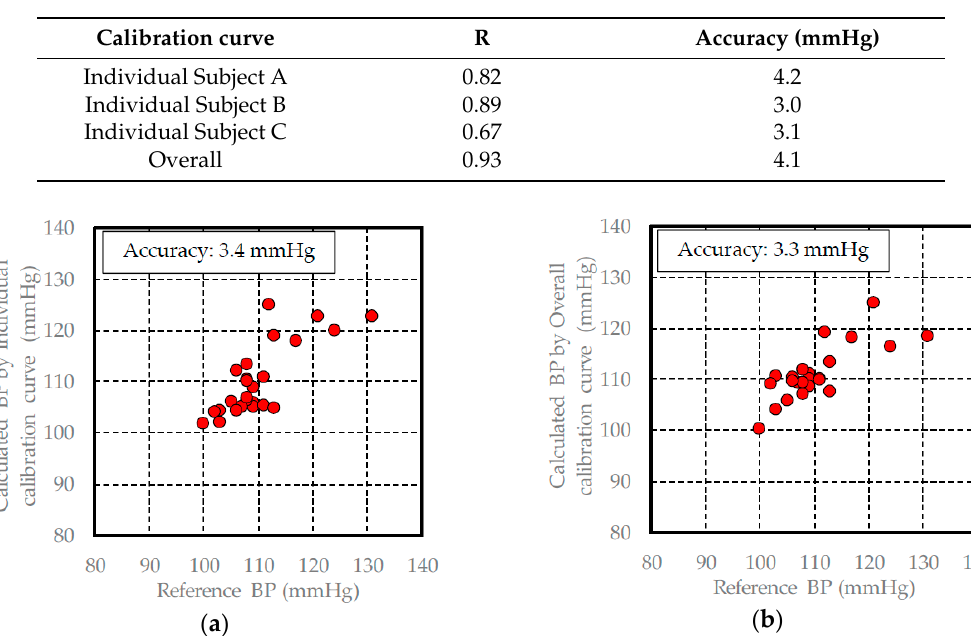
Table 3. Results of each individual calibration curve and overall calibration curve.